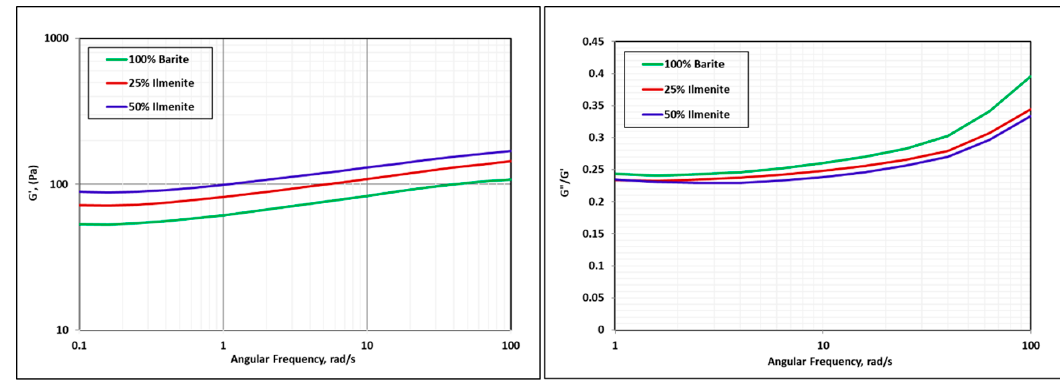
Figure 10. Effect of ilmenite on viscoelastic properties (250 °F).